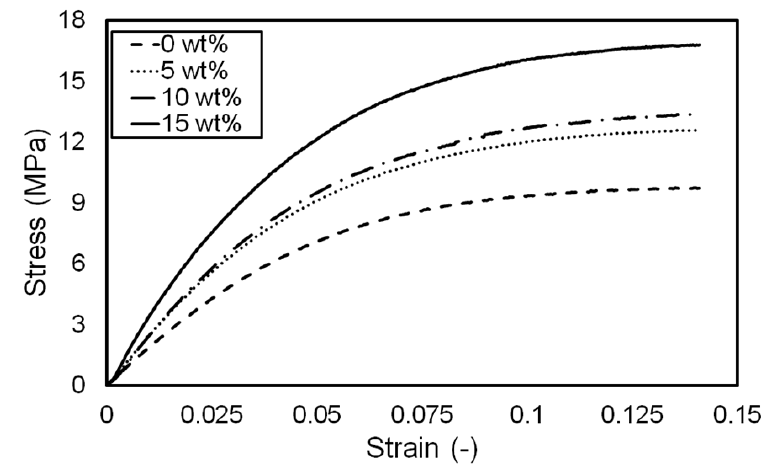
Figure 9. Stress–strain curves with respect to pigment concentration.